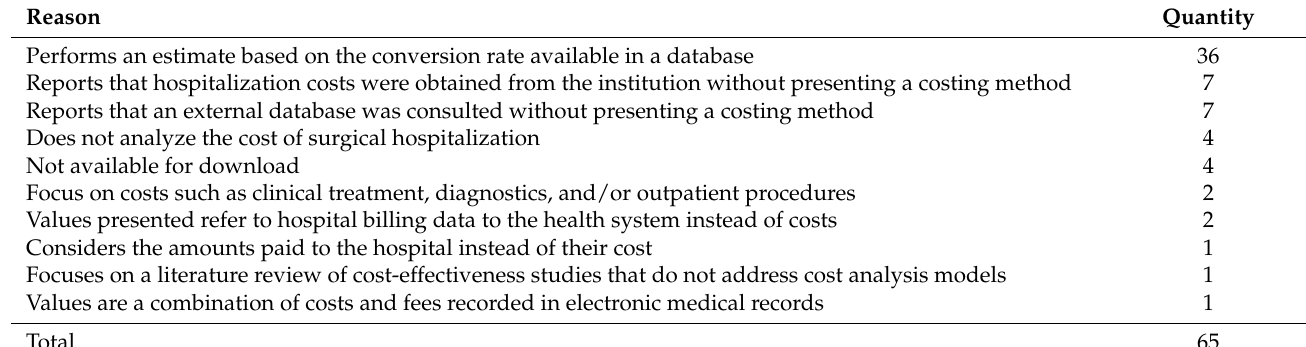
Table 1. Justifications for excluding the full texts.